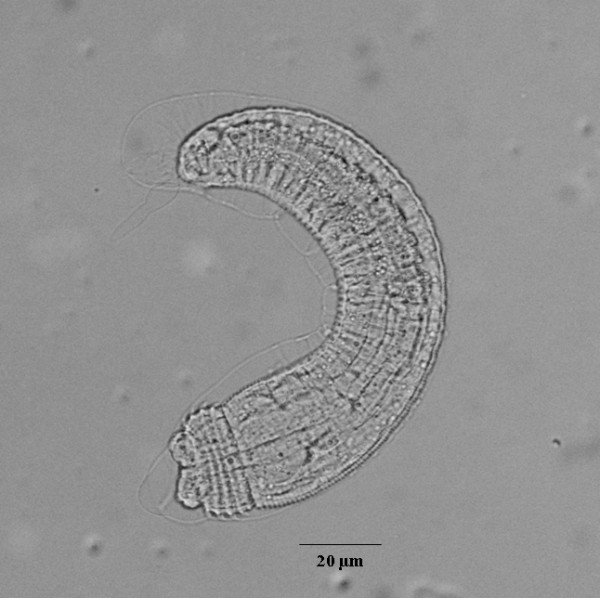
Five-day-old G. spinigerum larva. The molted cuticle extending slightly beyond the head and tail ends.